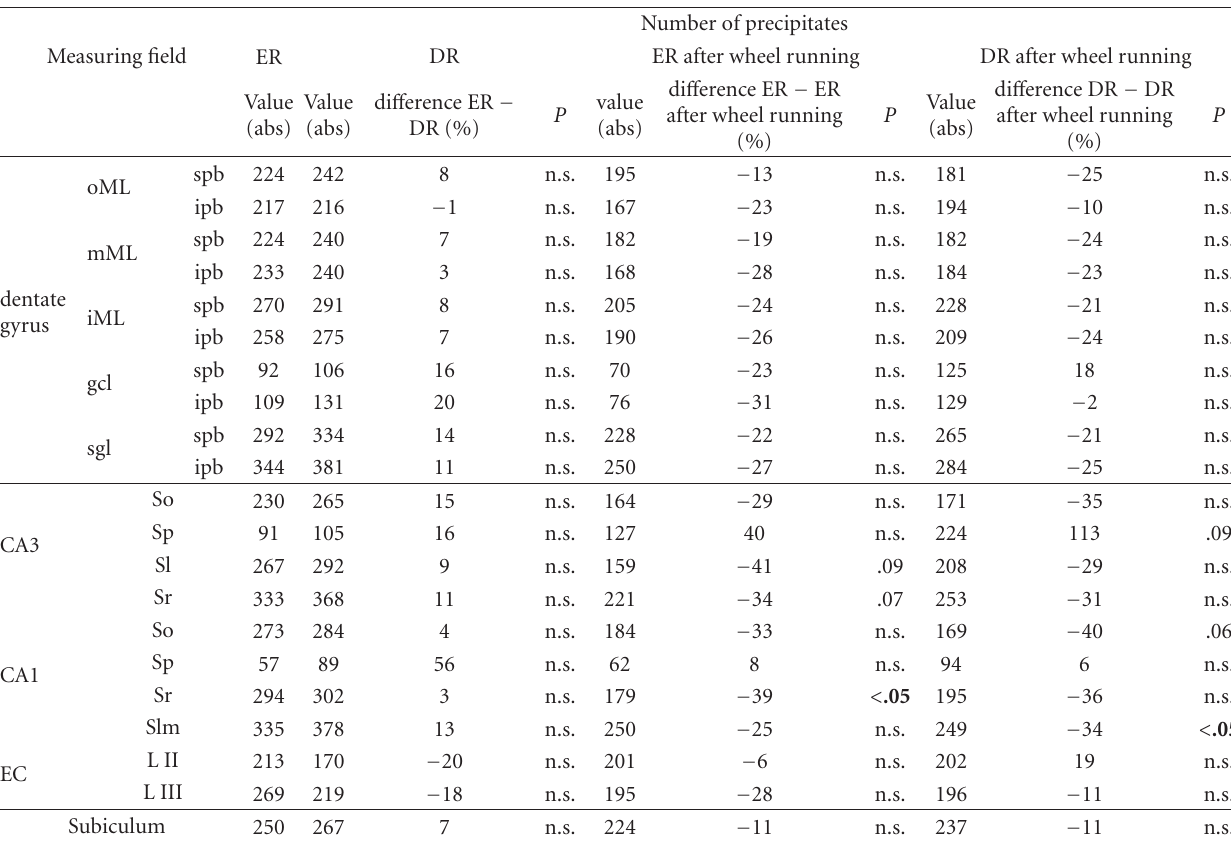
Number of precipitates